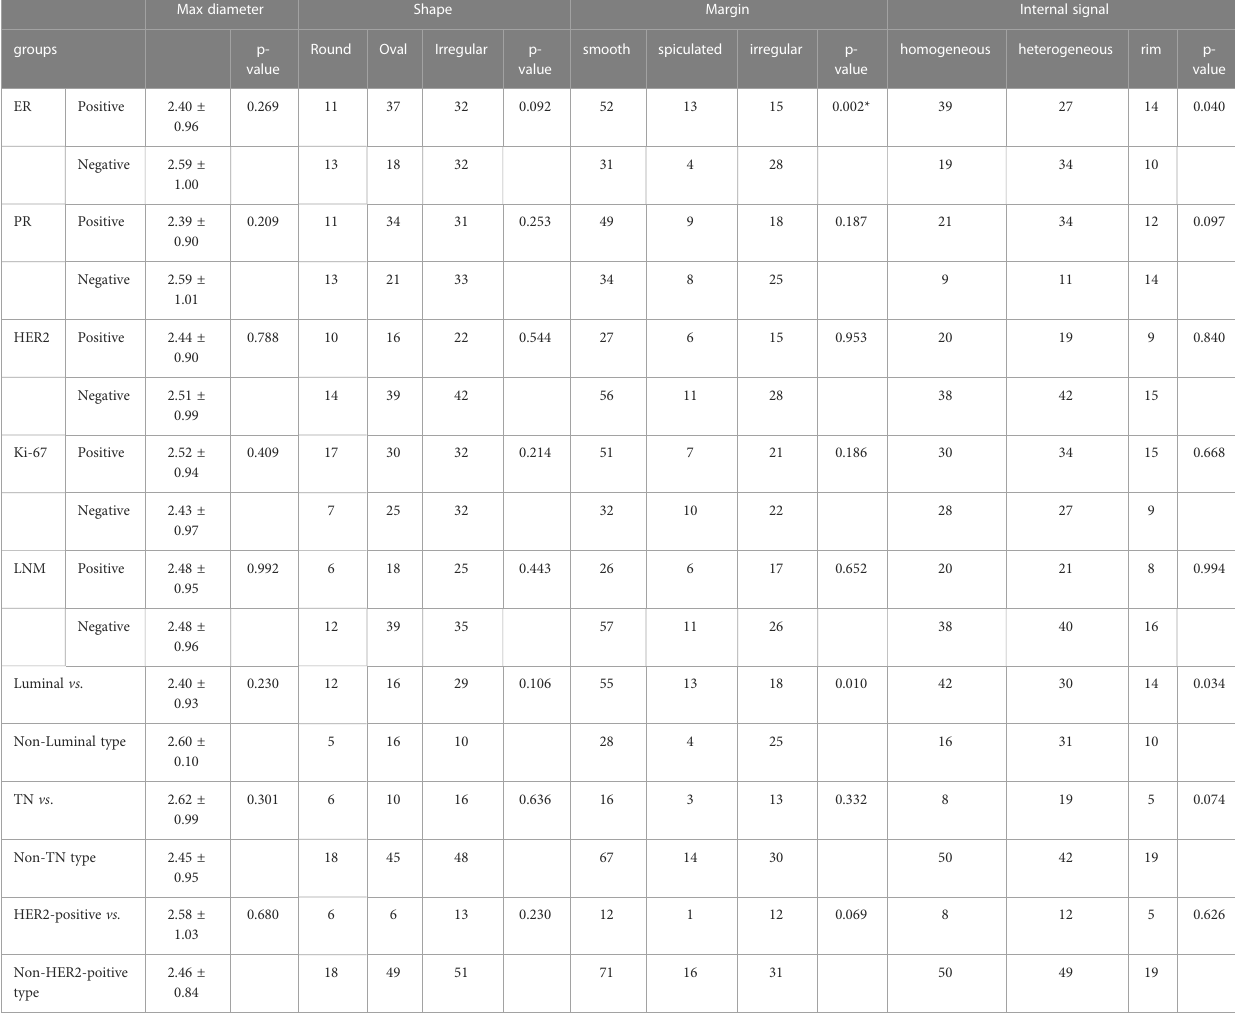
*indicates that the correlation is signi fi cant at the level of 0.00625 (double-tailed). ER, Estrogen receptor; PR, Progesterone receptor; HER2, Human epidermal growth factor receptor 2; LNM, Lymph nodes metastasis; TN,